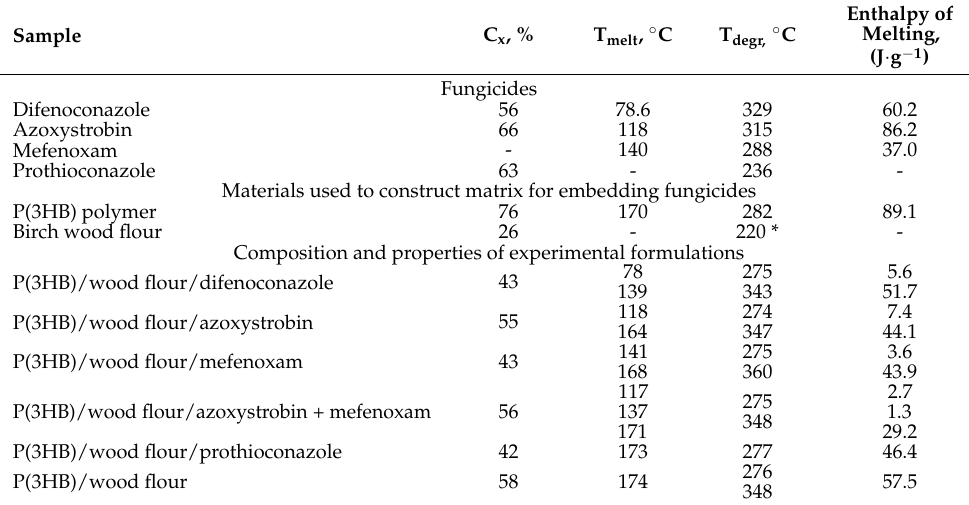
Table 2. Physico-chemical properties of the initial fungicides, materials of the matrix, and experimen- tal fungicide formulations.